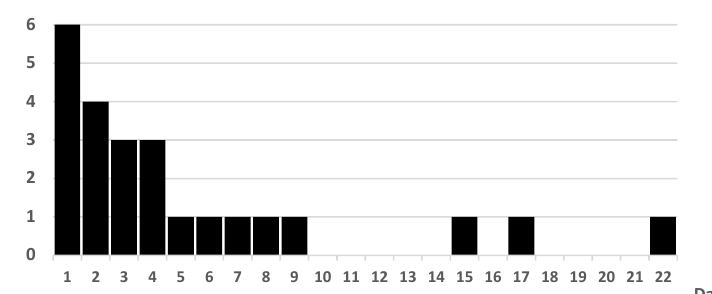
Figure 1. Number of cases and days from admission to PSP onset.